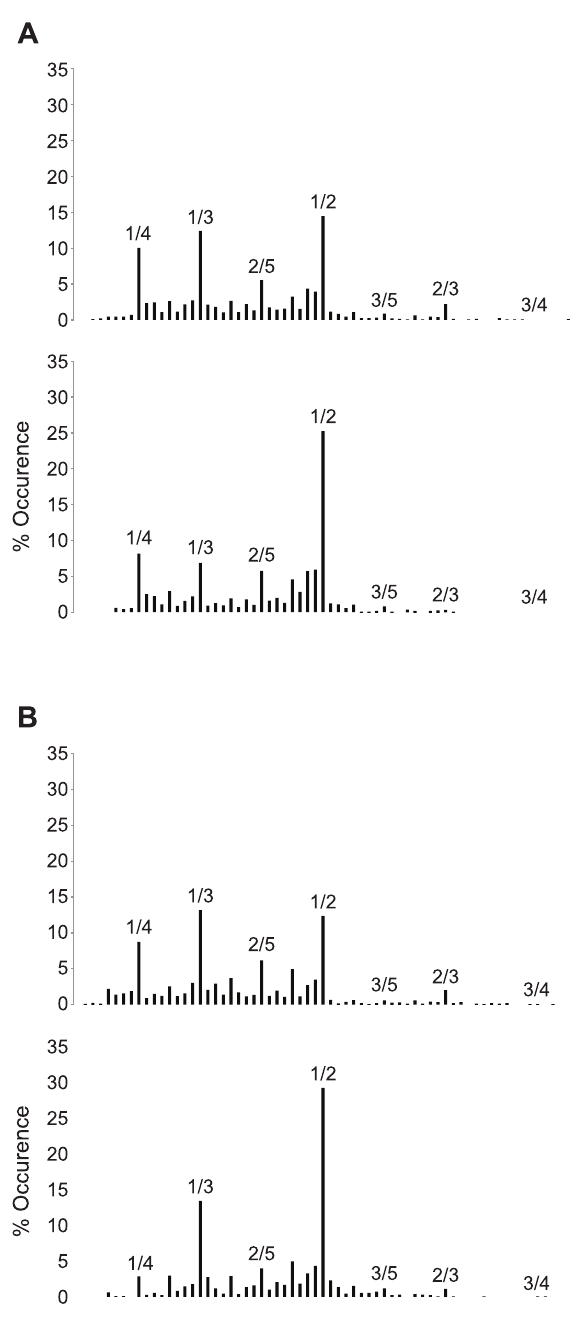
Figure 6. Distributions of the LRC frequency ratios in a six-level Farey tree for the two synchronization conditions. The first two panels represent the RESP condition and the two last correspond to the LOC condition. For each condition the upper panel corresponds to the No-Sound condition and the lower panel corresponds to the sound